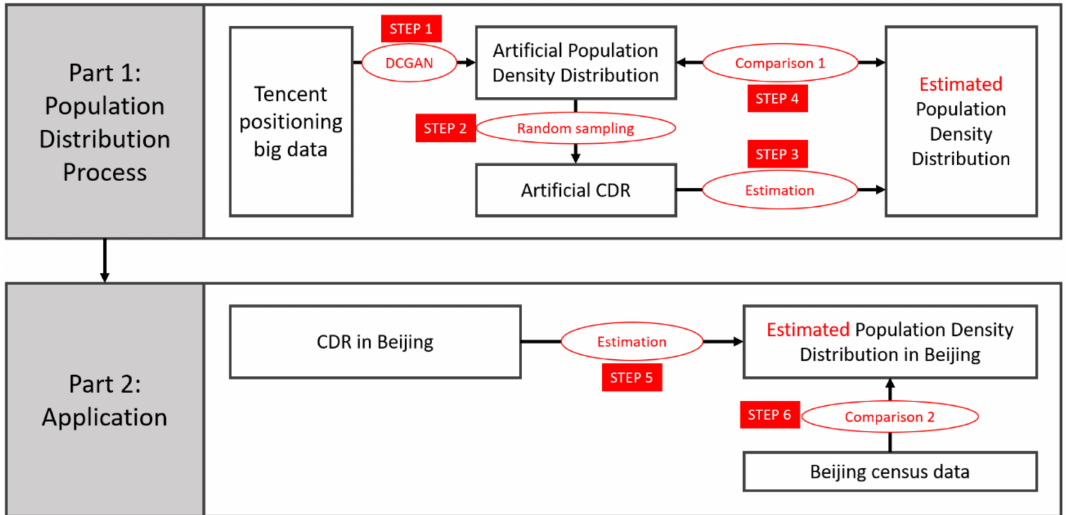
Figure 1. The overview of the call detail record (CDR)-driven population distribution